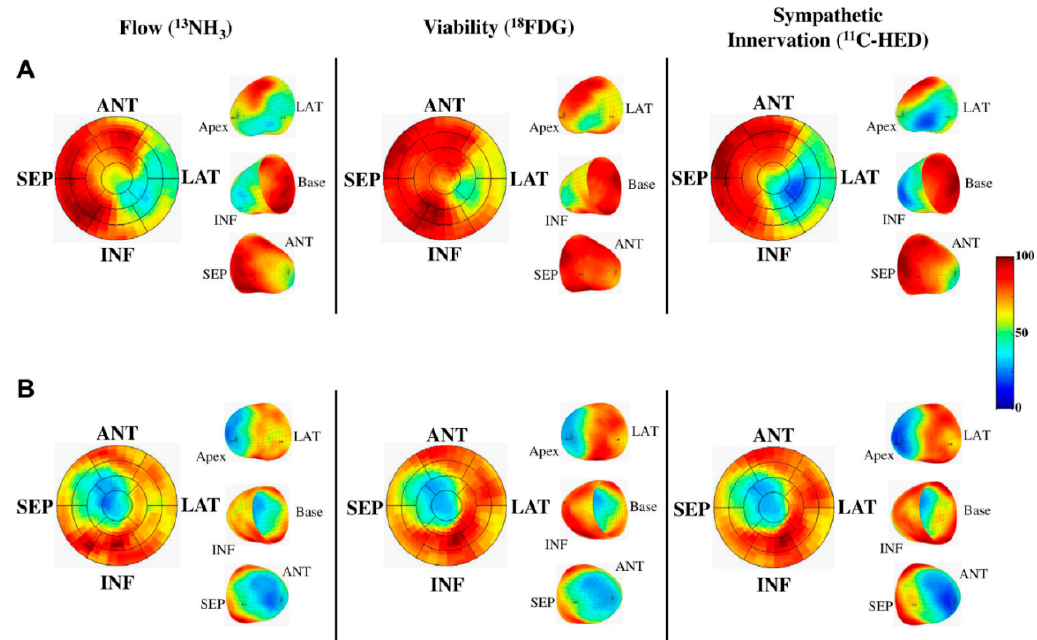
Figure 3. PET imaging of flow, viability and sympathetic innervation. ( A ) A subject experiencing sudden cardiac arrest (SCA). There is a mismatch in infarct size (reduced 18 F-2-deoxyglucose [ 18 FDG]), which was smaller than the volume of sympathetic denervation (reduced 11 C-meta-hydroxyephedrine [ 11 C-HED]). There was also reduced perfusion ( 13 N-ammonia [ 13 NH 3 ]) with preserved 18 FDG indicating hibernating myocardium. In contrast, ( B ) shows a subject with matched reductions in flow, infarct volume, and sympathetic denervation. ANT = anterior; INF = inferior; LAT = lateral; PET = positron emission tomography; SEP = septum [59].